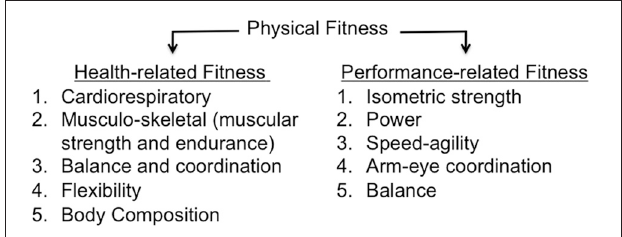
FIGURE 1 | Taxonomy of physical